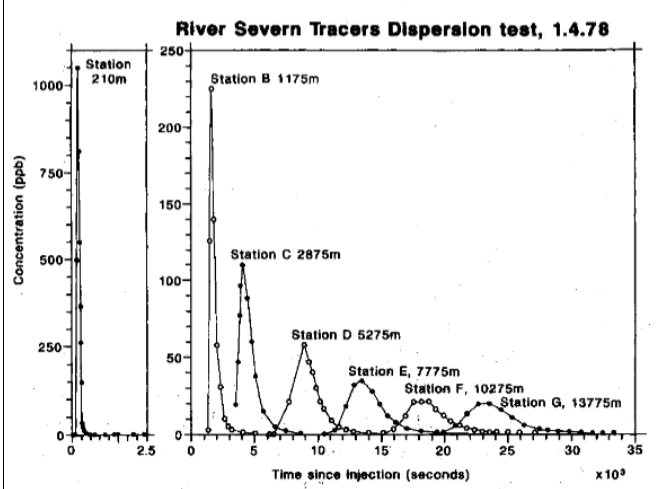
Figure 16: Distribution of Cp vs tp in the river Severn.